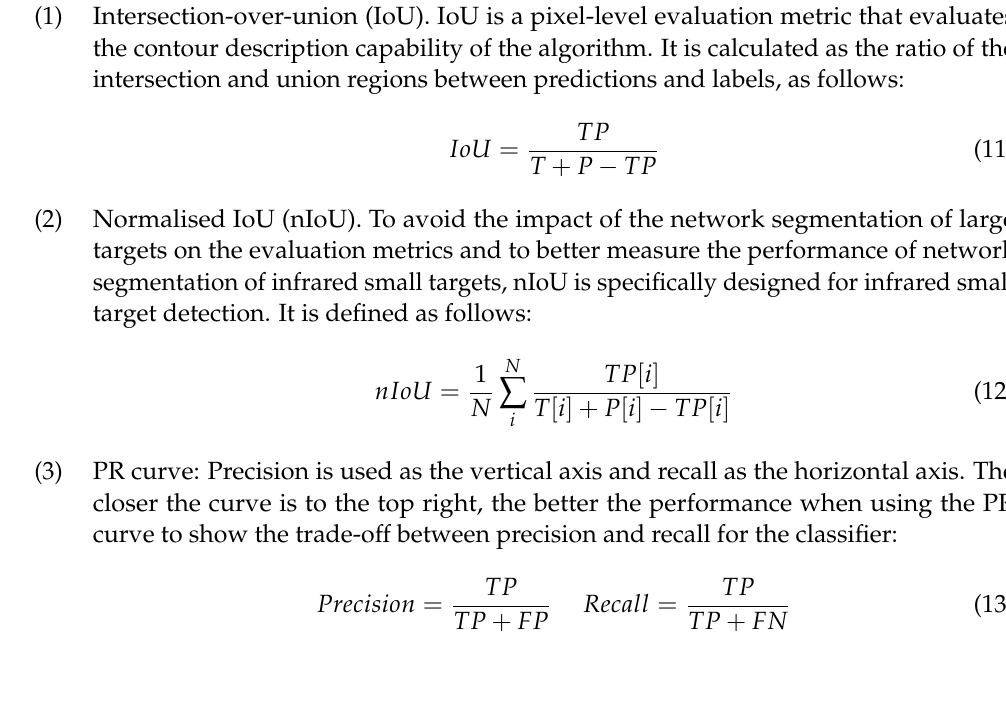
PR curve: Precision is used as the vertical axis and recall as the horizontal axis. The closer the curve is to the top right, the better the performance when using the PR curve to show the trade-off between precision and recall for the